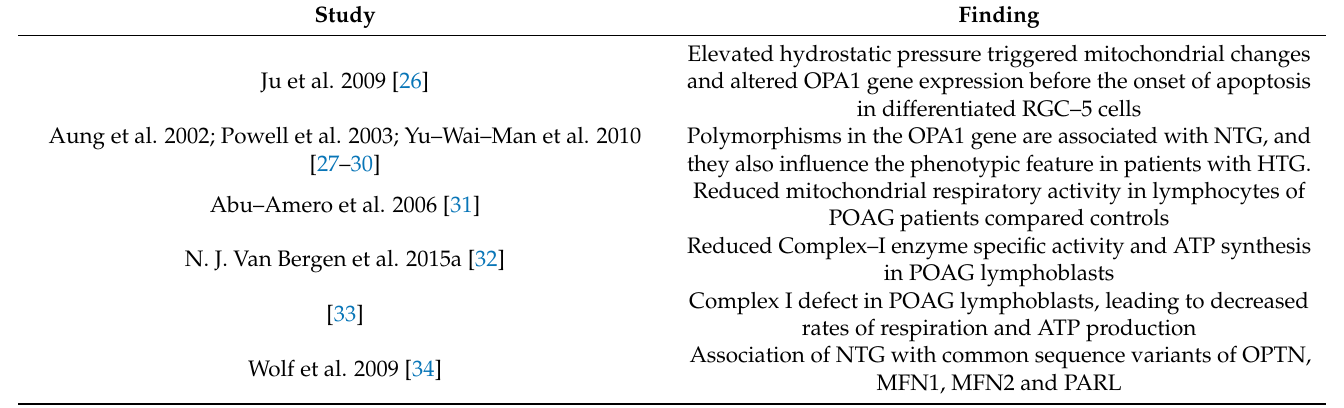
Table 1. Mitochondrial involvement in glaucoma patients and animal models of